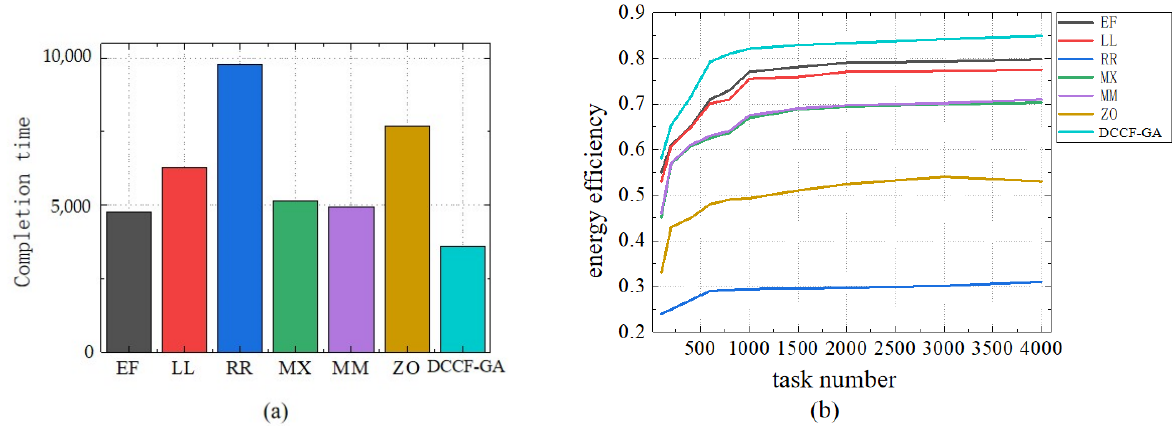
Figure 10. Performance comparison results with other algorithms. ( a ) Calculate the completion time of other six algorithms; ( b ) Calculate the energy consumption ratio of other six algorithms. By comparing the experimental results, it can be seen that DCCF-GA is superior to others.